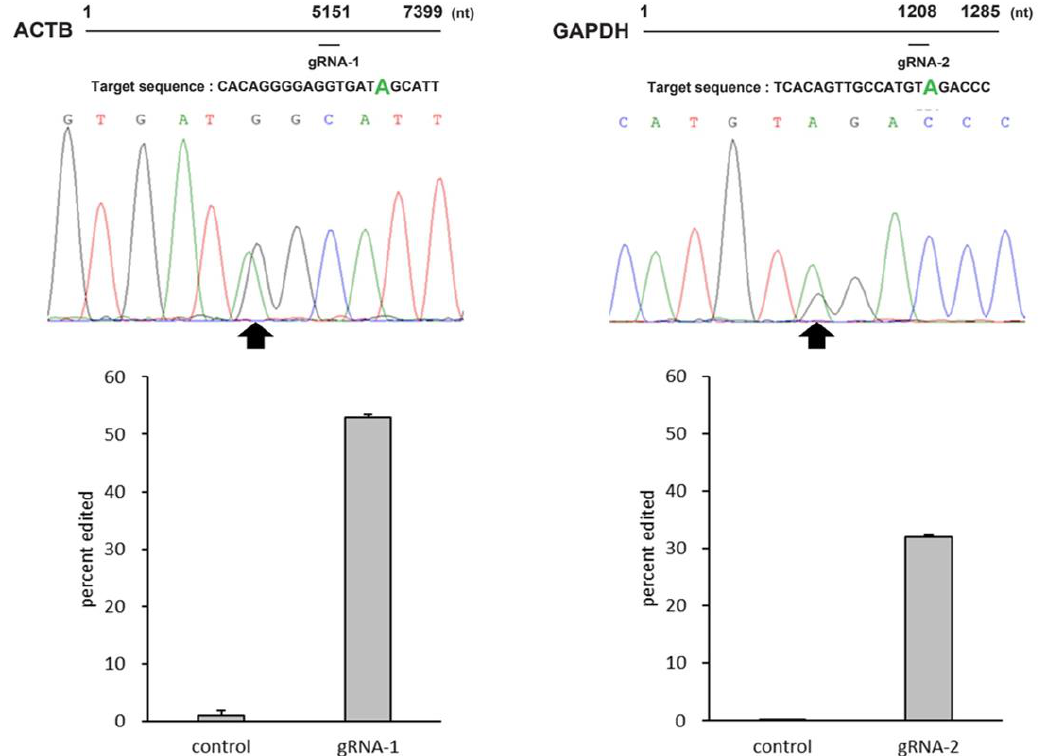
Figure 4. ACTB (left) and GAPDH (right) targeted base (green), the waveform data around the target site and bar graphs indicating the editing efficiencies. Black arrows indicate the target base for each gene. Error bars represent standard error ( n = 3).